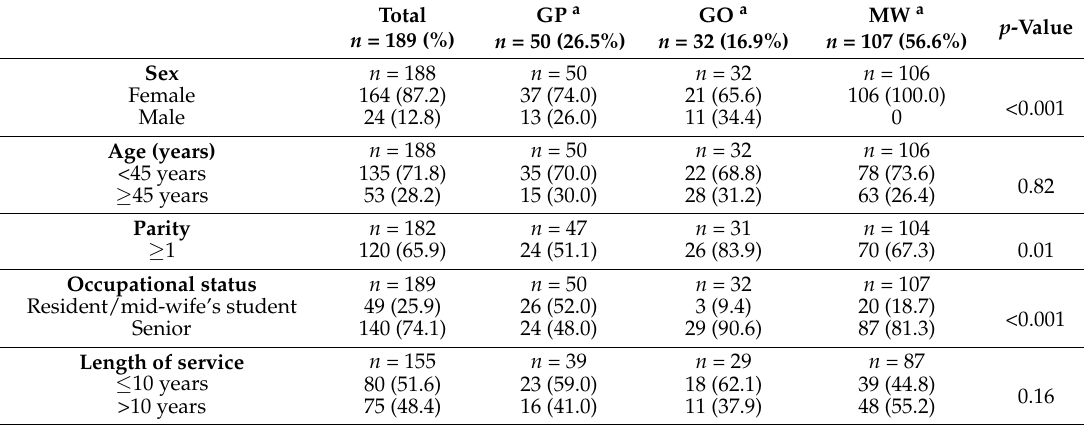
Table 1. Sociodemographic and professional characteristics of perinatal health professionals